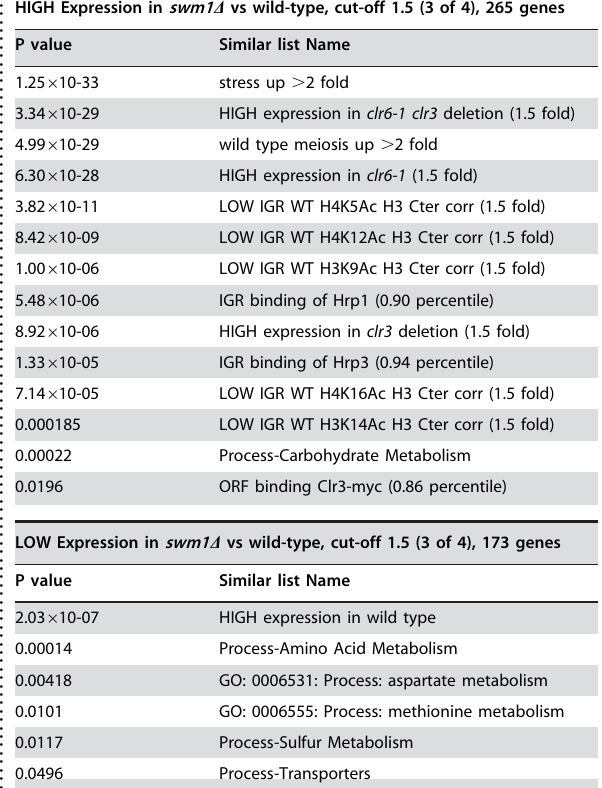
Table 2. Hyper-geometric probability comparisons of IGR and ORF lists with high H3K4me2 in swm1 deletion cells. ... ... ... .... ... ... .... ... ... .... ... ... .... ... ... .... ... ... .... ... ...